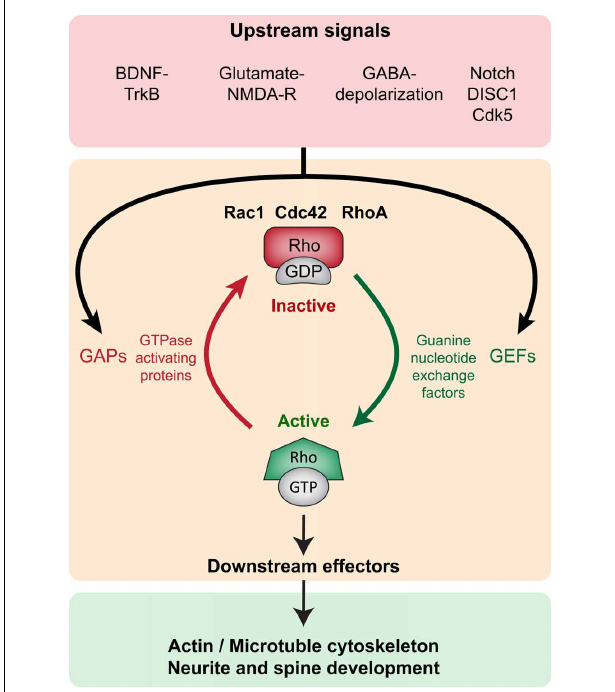
FIGURE 2 | Small Rho GTPase signaling in neurite and spine maturation (Top panel, red). Upstream signaling such as BDNF-TrkB, Glutamate-NMDAR, GABA-induced depolarization, Notch, DISC1 and Cdk5 modulate small Rho GTPase activity. (Middle panel, orange) Upstream signals modulate GEFs and GAPs thereby regulating the activity of small Rho GTPases Rac1, Cdc42, and RhoA. GEFs promote activation (GTP-bound conformation) and GAPs promote inactivation (GDP-boundconformation). (Bottom panel, green) In the active state, small Rho GTPases bind to several downstream effectors exerting influence on local actin and microtubule networks, thereby influencing neurite and spine